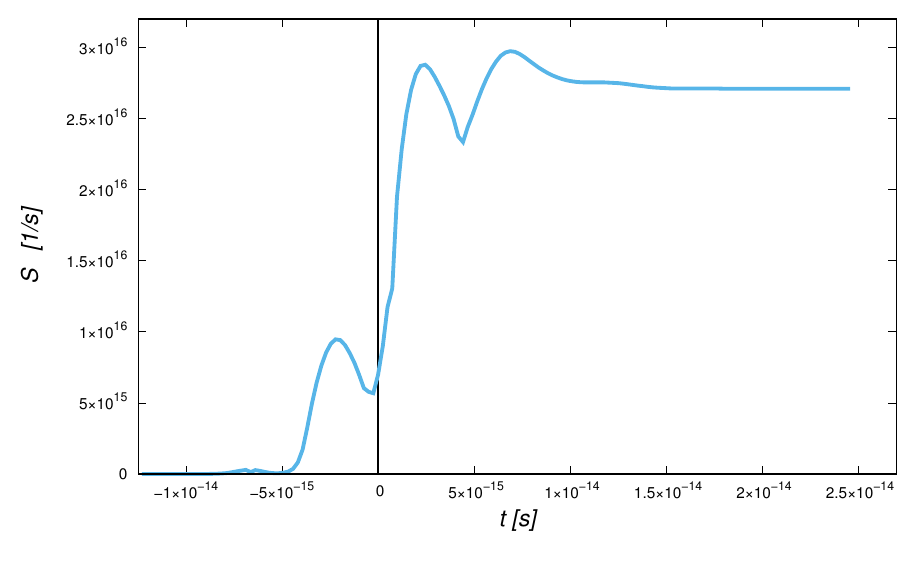
Figure 5. Time dependence of the collision integral S γ ( k , t )